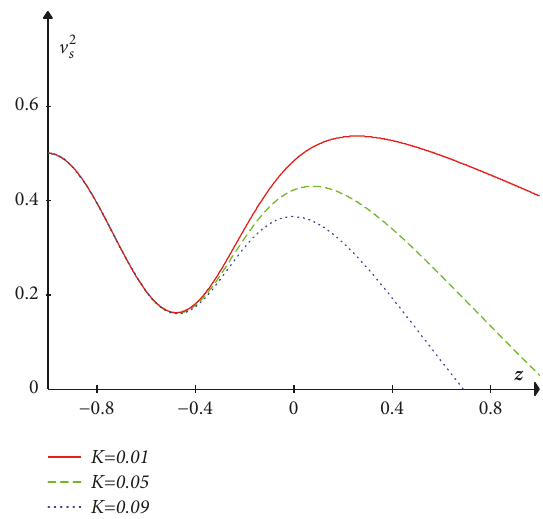
Figure 5: The plot of sound speed V 2 𝑠 versus redshift 𝑧 in non- interacting case for 𝛼 = 1, 𝛽 = 1 , Ω 𝑚 0 = 0.3, 𝜔 = 1 𝜔 𝑚 = 0 , and vary 𝐾 = 0.01 , 0.05, 0.09, resp.